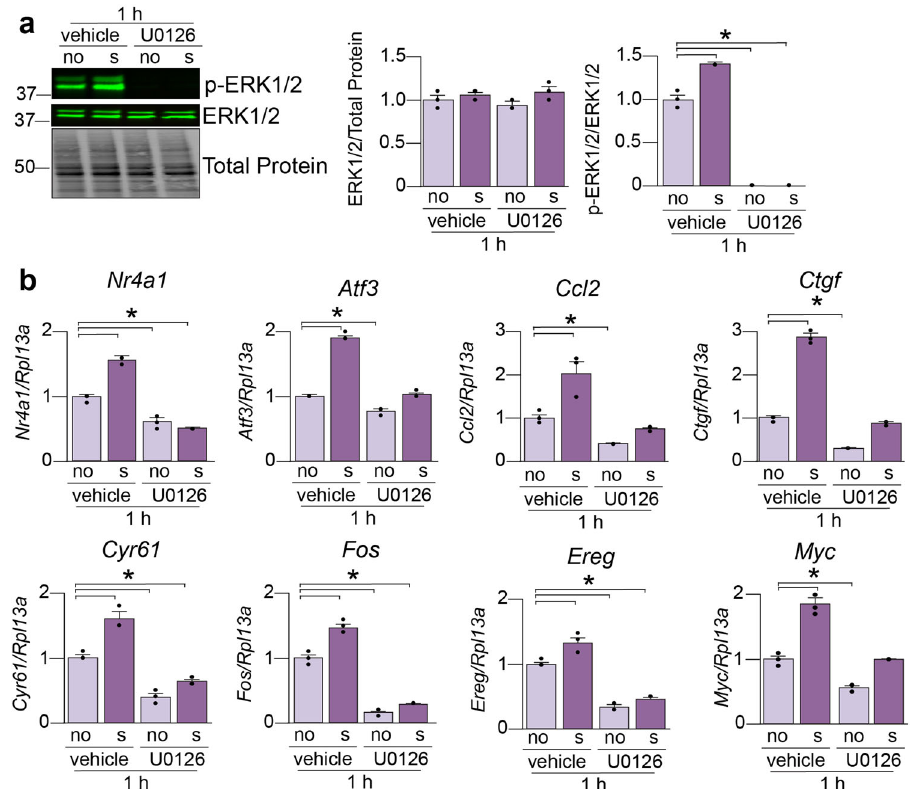
Fig. 3 Inhibition of ERK1/2 phosphorylation impacts the response of mechanosensitive genes. a Differentiated muscle cells were treated with the ERK1/ 2 phosphorylation inhibitor U0126 and stretched for 1 h. Western blot assays were performed and quanti fi ed by densitometry to examine total ERK1/2 and phosphorylated ERK1/2 (p-ERK1/2) levels. b qPCR assays were performed and quanti fi ed to examine the mRNA expression changes of eight mechanosensitive genes. Results are shown as mean ± SEM, N = 3. * p < 0.05, one-way ANOVA with Dunnett ’ s post hoc multiple comparisons